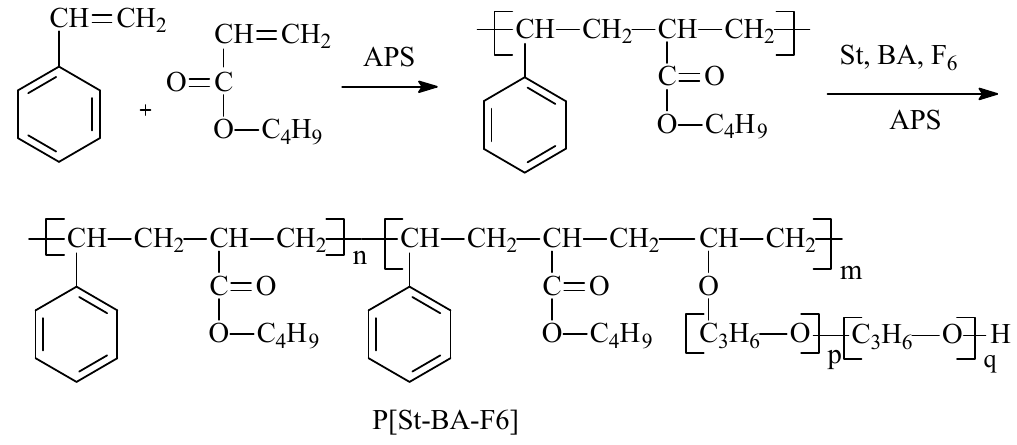
Figure 1. Flowchart of synthesis of P[St-BA-F6].